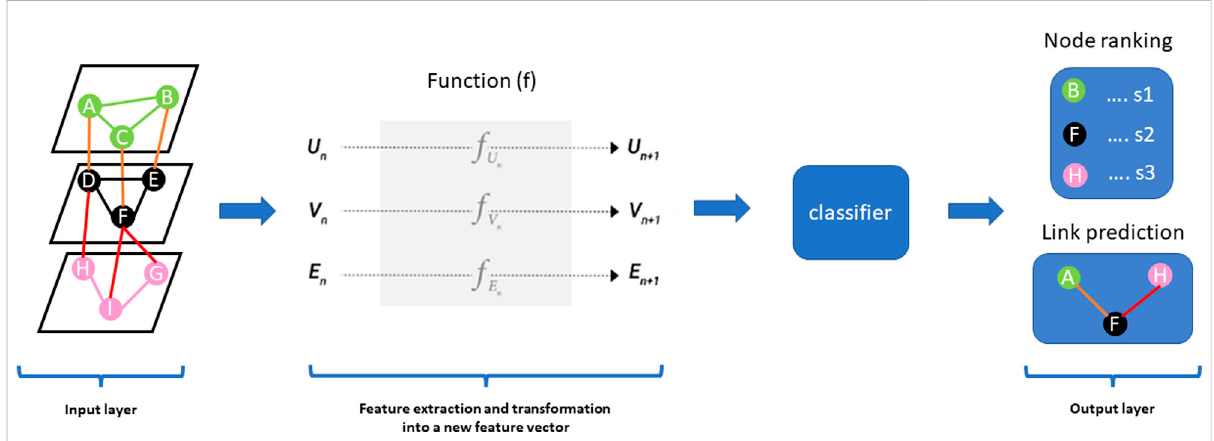
FIGURE 2 Graph Neural Networks (GNNs) are a class of deep learning methods designed to perform inference and predictions on graph data by learning embeddingsfor graph attributes(nodes,edges,global-context).The concept behind thearchitectureofthese methods issuchthat itaccepts graph data as input and produces the same input graph with updated embeddings before making predictions. GNN uses a function (f) on each graph component vector [nodes vector (Vn), edge vector (En), global-context vector (Un)] in the input graph to learn abstract feature representations of the graph to compute a new feature vector for nodes (Vn+1), edges (En+1) and global-context (Un+1)). The output layer could predict nodes ranked according to a particular score (s1, s2, s3) and also predict edges (links) in the input